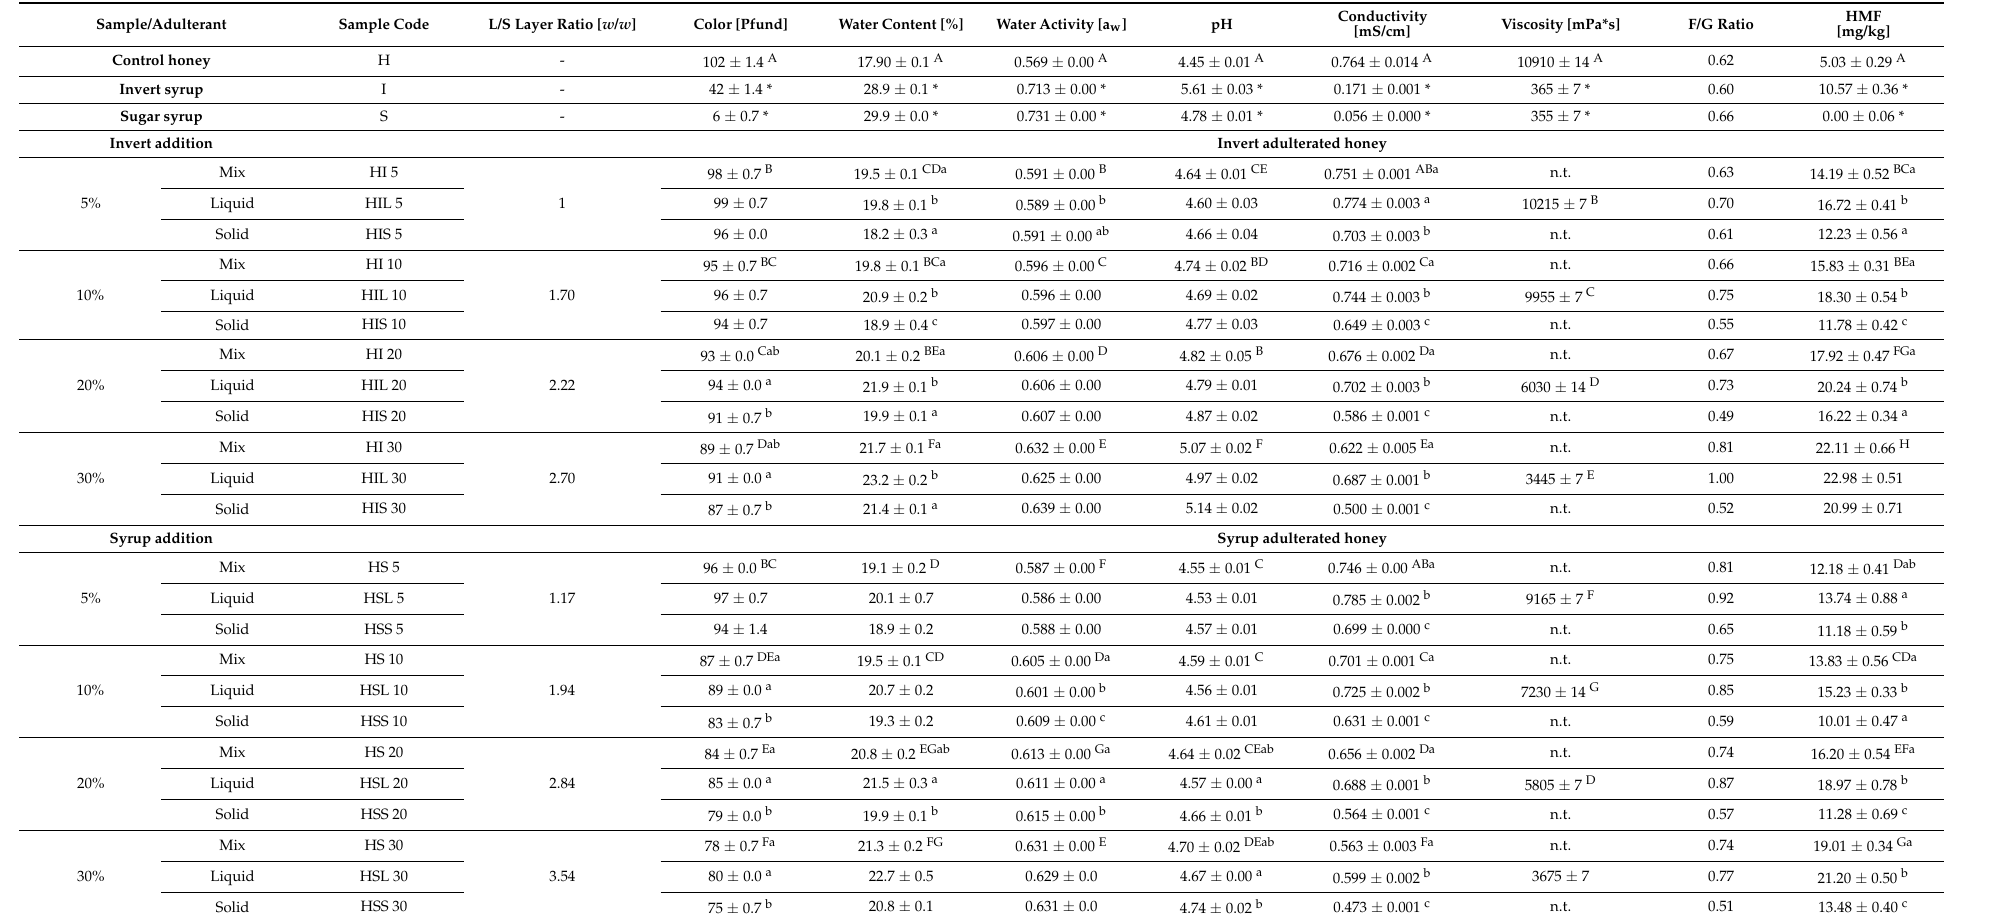
Table 1. Physicochemical parameters of adulterated honey